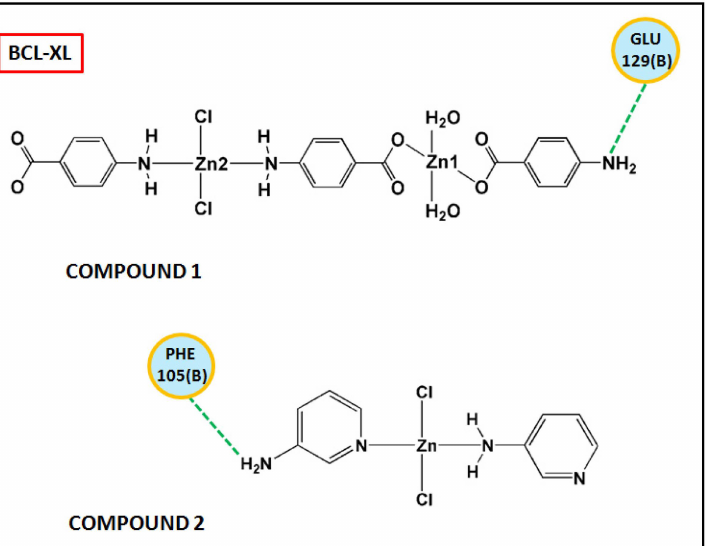
Figure 18. Chemical interactions of modelled fragments of the compounds with BCL-XL have been represented with compounds’ atoms and interacting amino acid